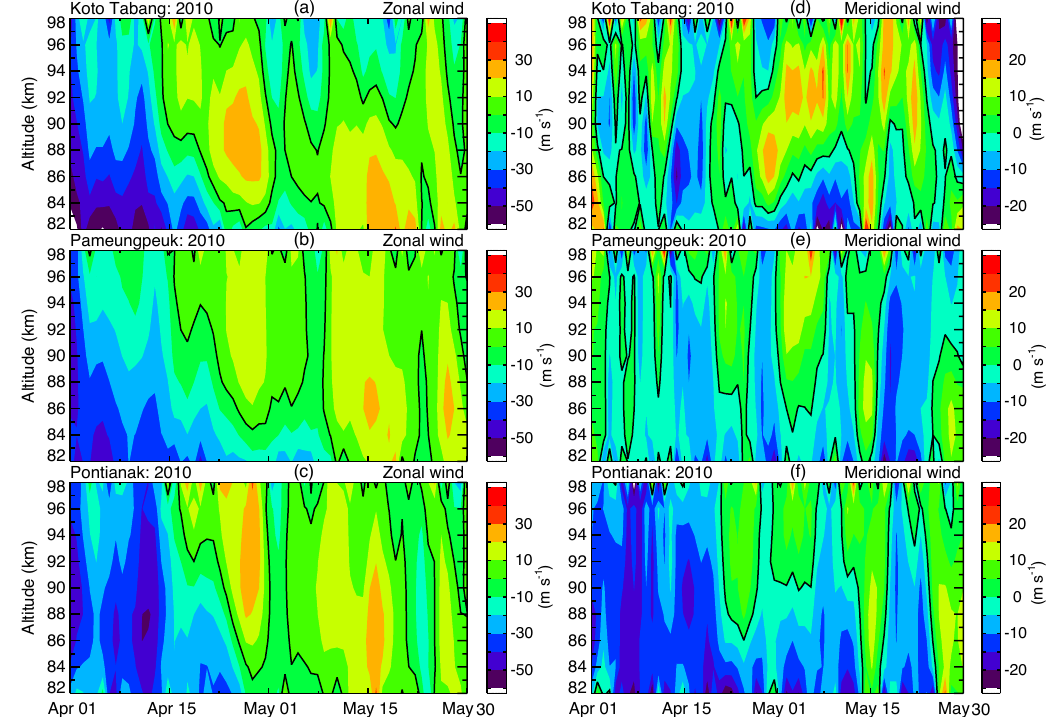
Figure 1. Time–altitude sections of the daily mean zonal (a, b, c) and meridional (d, e, f) winds over Kototabang, Pameungpeuk, and Pontianak locations during the period from 1 April to 31 May